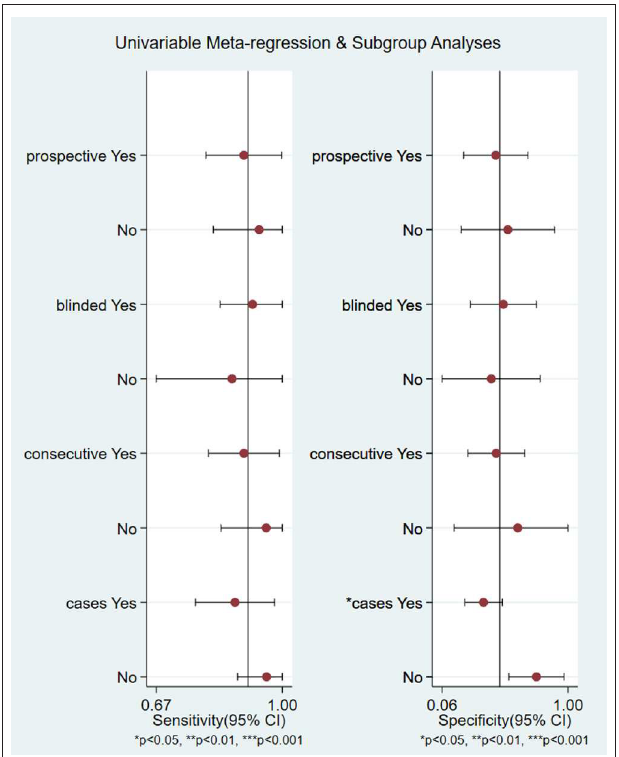
FIGURE 5 | The detailed data for the univariable meta-regression analysis and subgroup analysis.